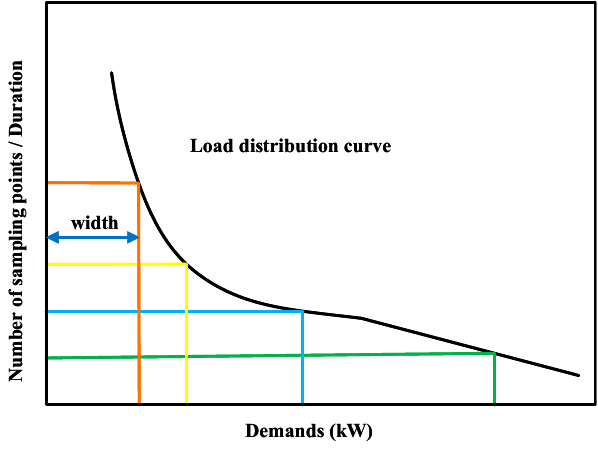
Figure 1. An example of the maximum rectangle (MR) design method.